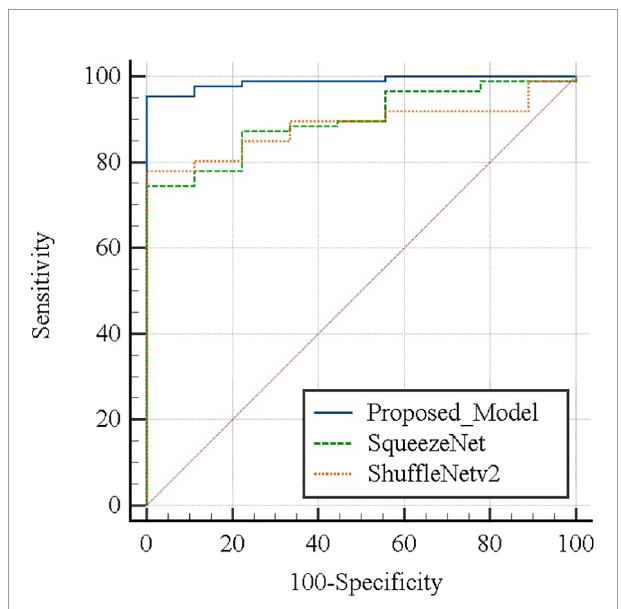
FIGURE 10 | Areas under the ROC curve between each model were compared using the method of DeLong et al.